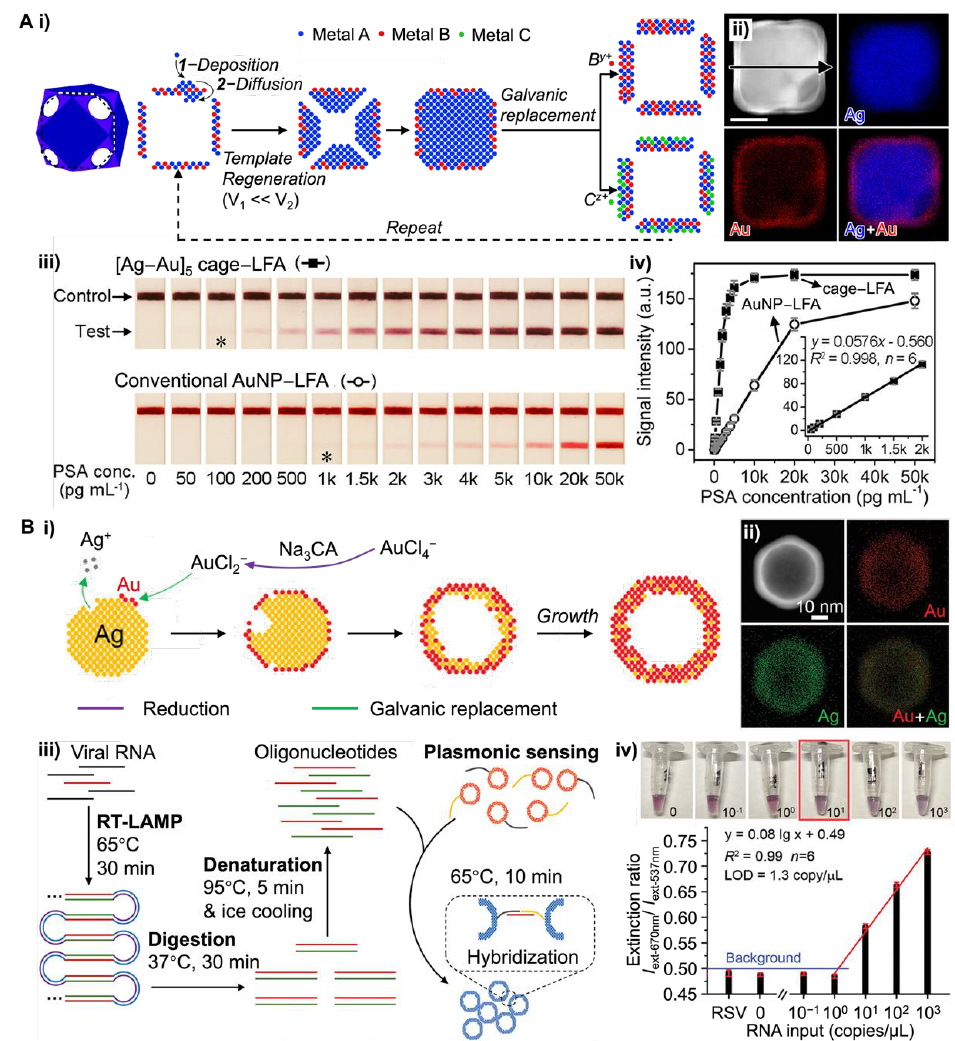
Figure 4. NM NPs with improved plasmonic resonance enabled ultrasensitive POC testing. ( A ) Au- Ag nanocages-based LFA: ( i ) schematic illustration showing the approach of template regeneration and galvanic replacement for the synthesis of metallic nanocages with controlled wall thicknesses; ( ii ) EDX mapping images of an individual Ag@Au-Ag core@shell nanostructure; ( iii ) LFAs for PSA detection using advanced Au-Ag nanocages and conventional Au NPs, respectively. The asterisks (*) indicate detection limits by the naked eyes; ( iv ) calibration curves of the detection results in ( iii ) by quantifying the intensity of testing lines against PSA concentrations. Adapted with permission from ref [60]. Copyright 2020 American Chemical Society. ( B ) Au-Ag nanoshells-based plasmonic LAMP: ( i ) schematics showing the simplified growth of the hollow nanoshells by galvanic replacement; ( ii ) EDX mapping images of an individual Au-Ag shell; ( iii ) concept of the plasmonic LAMP for viral RNA detection; ( iv ) plasmonic LAMP achieved a limit of detection at 1.3 copy/ µ L for SARS-CoV-2 RNA. Adapted with permission from ref [63]. Copyright 2022